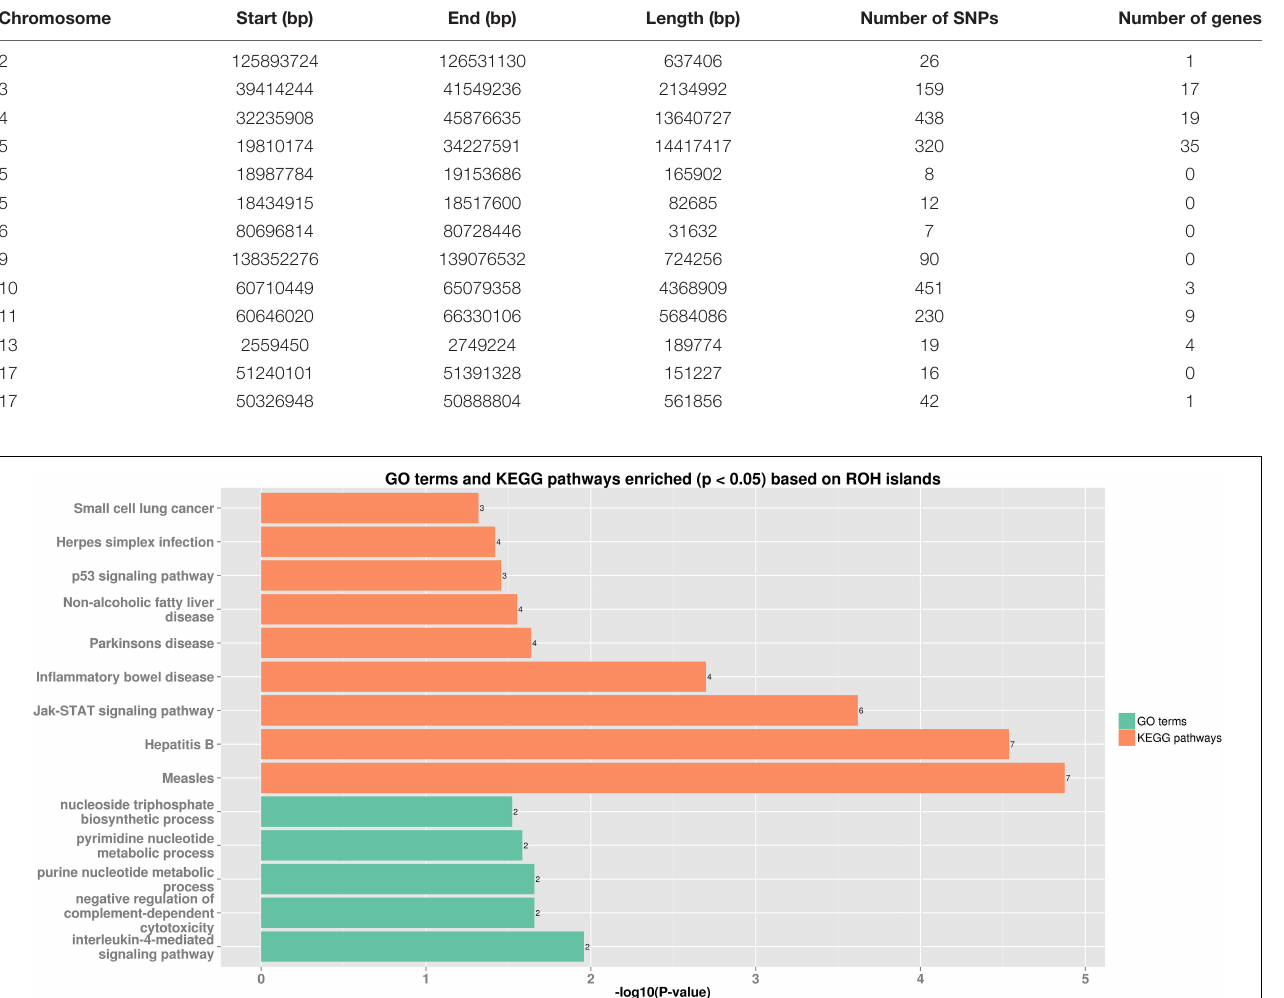
also indicate the consequence of a decreased population size and bottleneck